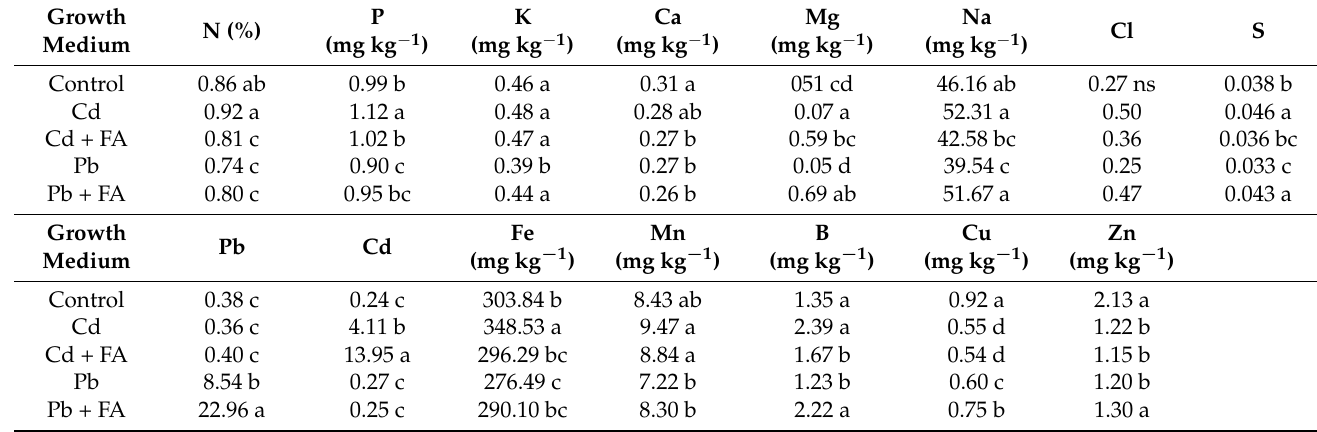
Table 5. The root part macro and micro element analysis results of Zinnia elegans .